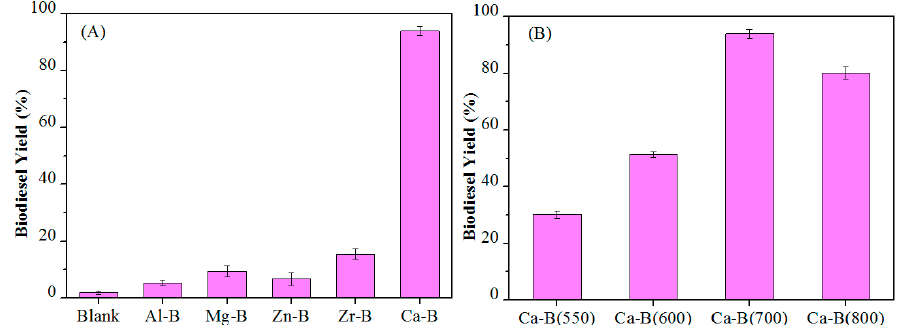
Figure 4. ( A ) Activity of different metal-B catalysts calcined at 700 °C in biodiesel production, and ( B ) Effect of calcination temperature for Ca-B catalysts on the biodiesel production. Reaction conditions: 2.0 g oil, 1.30 g methanol, 0.12 g catalyst, T = 85 °C, t = 6 h.